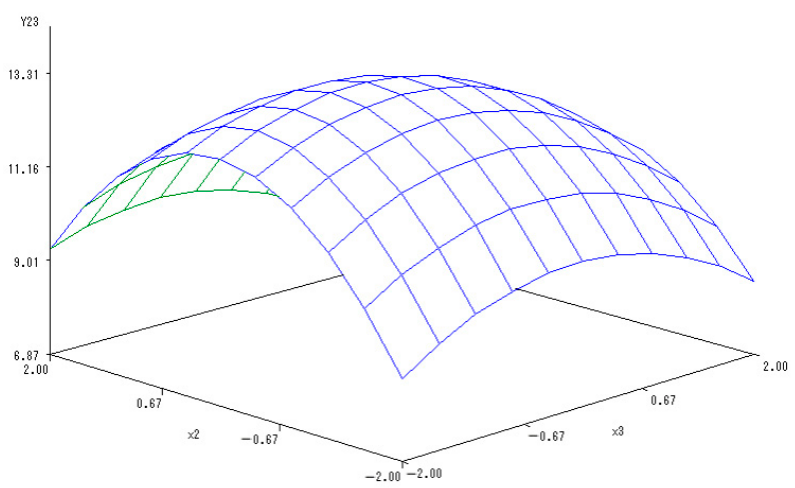
Figure 9. The 3-D map of mutual effect of P and K fertilizers application on the content of soluble sugar in melon.